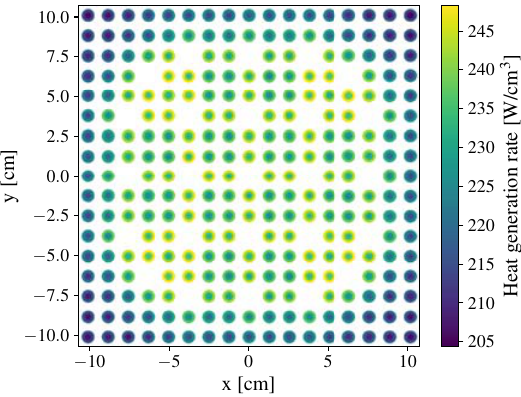
Figure 5: Heat generation rate at z = 100 cm as calculated by